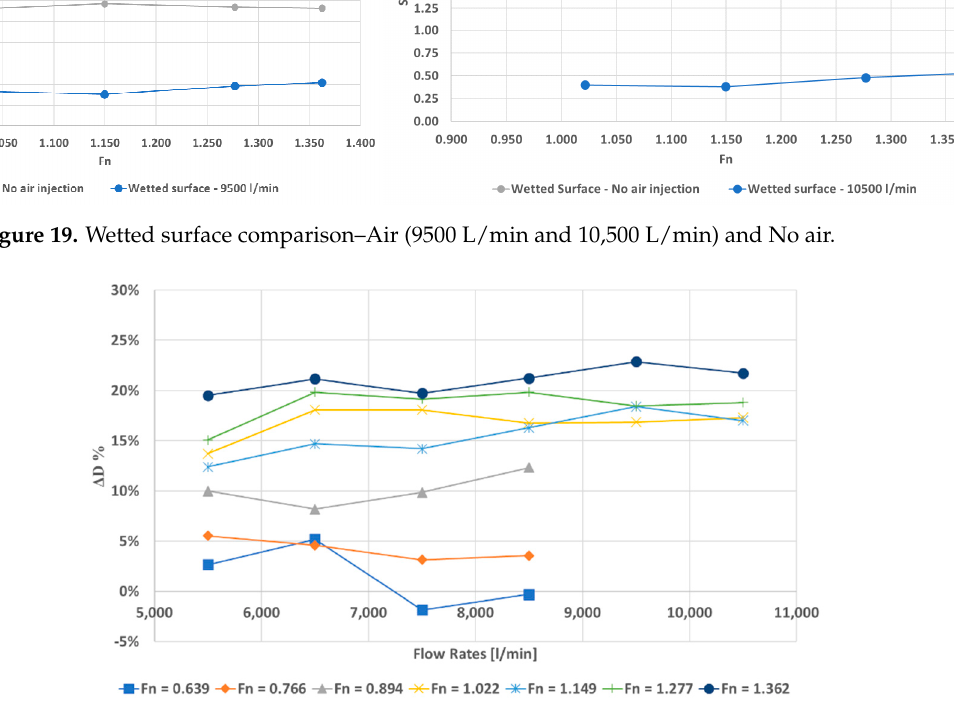
Figure 20. Reduction of resistance vs flow rate to the same Fn.